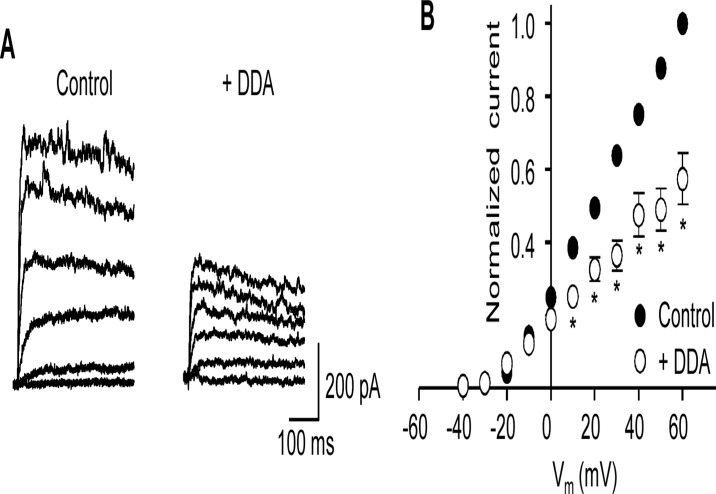
The adenlylate cyclase inhibitor, dideoxyadenosine attenuates Kv current.(A) Representative Kv current traces before (control) and after application of 50 μM 2’,5’-dideoxyadenosine (DDA). (B) Mean (± s.e.m.) I-V plots (normalized to control current at +60 mV) before (control) and after application of DDA. *P<0.05; two-way ANOVA, Bonferroni’s post hoc test.